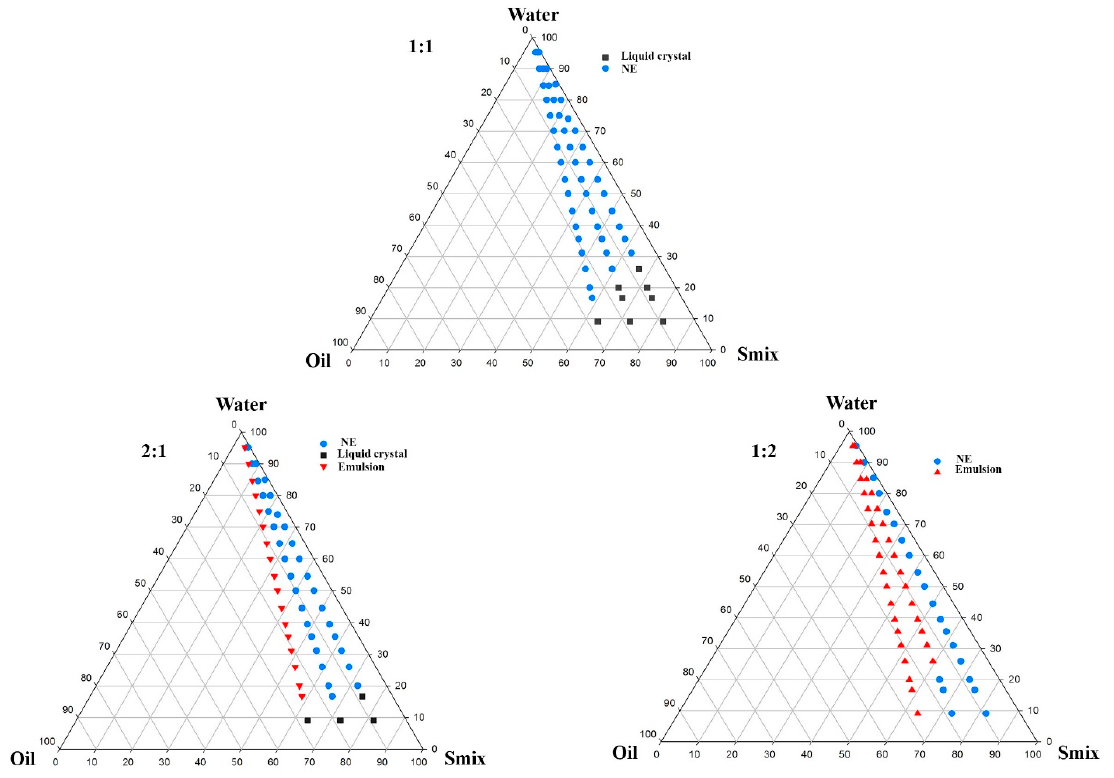
Figure 3. Phase behavior study at Smix ratios of 1:1, 2:1, and 1:2.